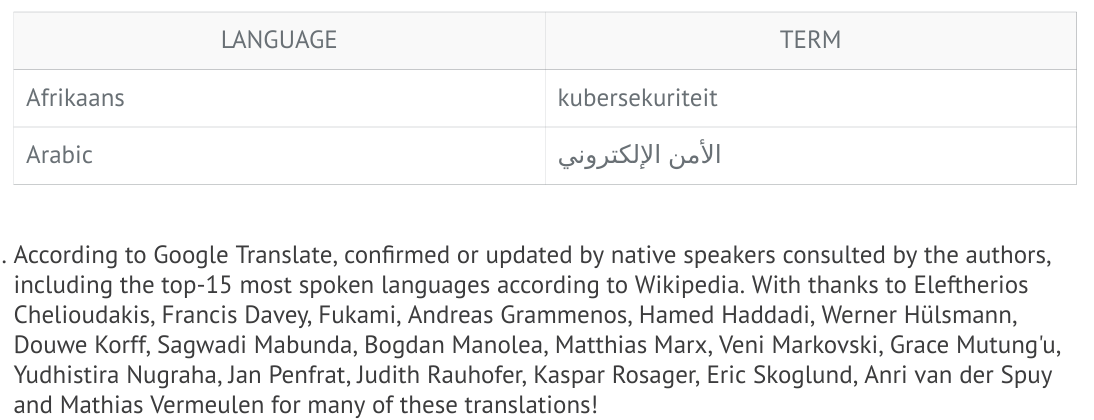
TABLE 1: Terms for cybersecurity (via Google Translate on 14 September 2020, checked against by native